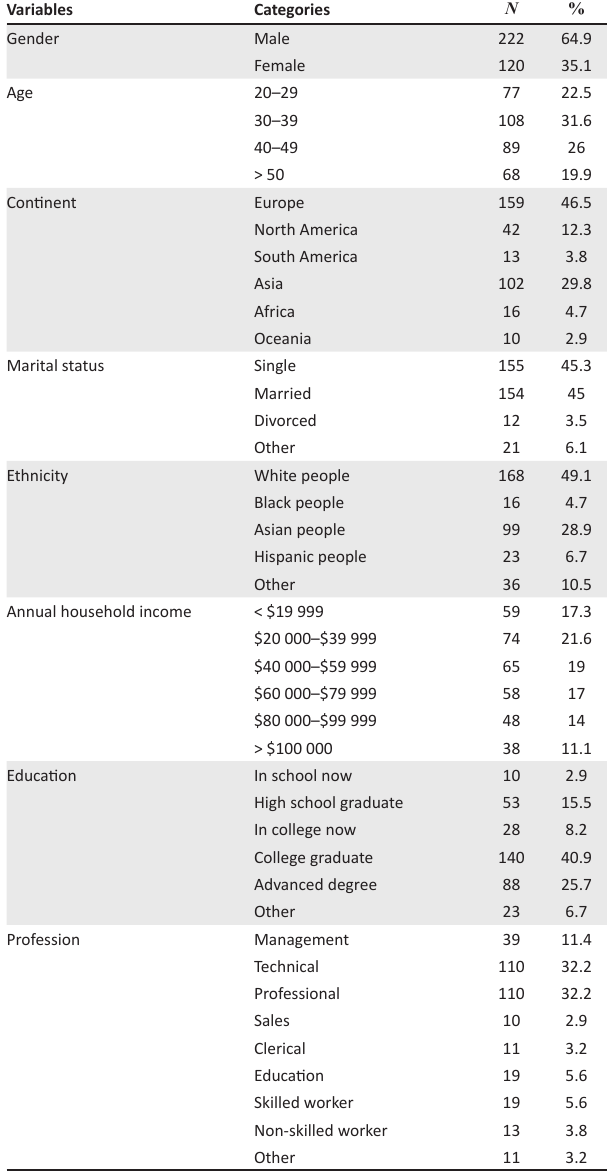
TABLE 1: Demographic characteristic of participants.